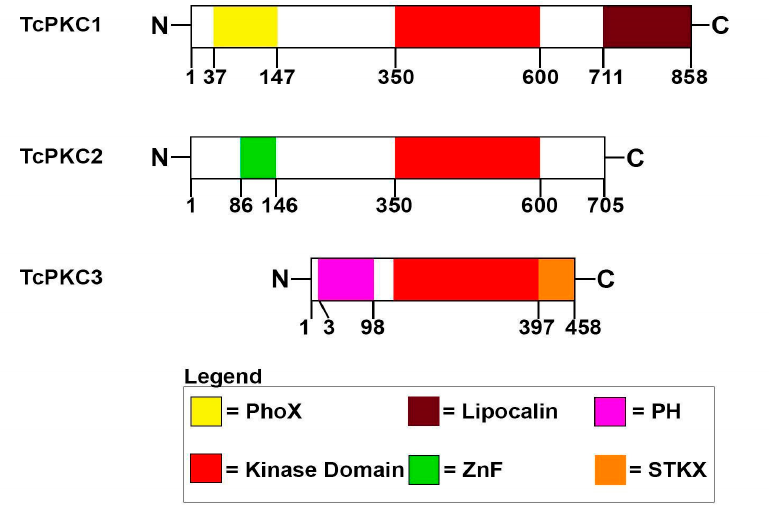
Figure 3. Schematic representation of TcPKC1, TcPKC2 and TcPKC3. By searching the T. cruzi genome database, three putative PKCs were found: TcPKC1 (ESS64742), TcPKC2 (PWV04907) and TcPKC3 (XP_809943.1). Bioinformatic analysis indicated that those polypeptides contained different domains, which are indicated at the bottom of the figure. PhoX, PH and the ZnF domain are predicted to bind PIPs. The kinase domain is the catalytic domain found in the AGC protein kinases family. The lipocalin domain is predicted to bind free fatty acids, whereas the STKX domain is found in some protein kinases.